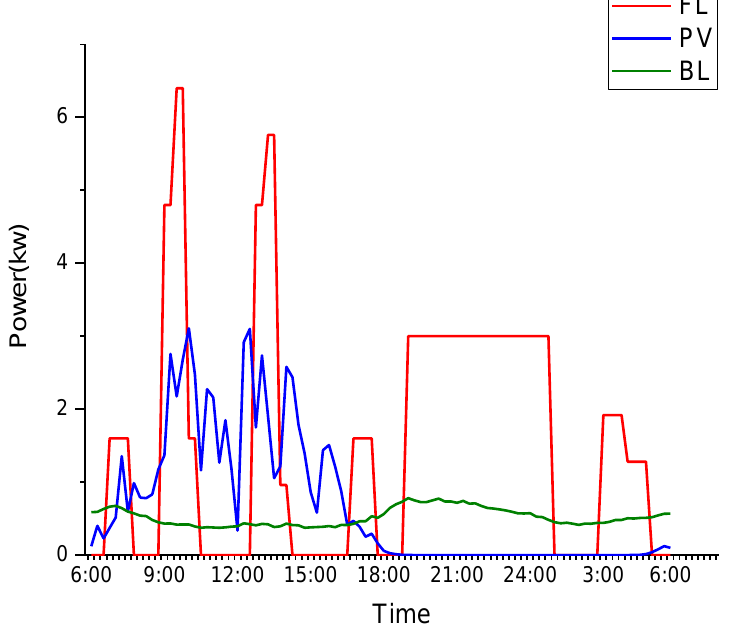
Figure 4. The power of photovoltaic power generation (PV), basic load (BL) and flexible load (FL).